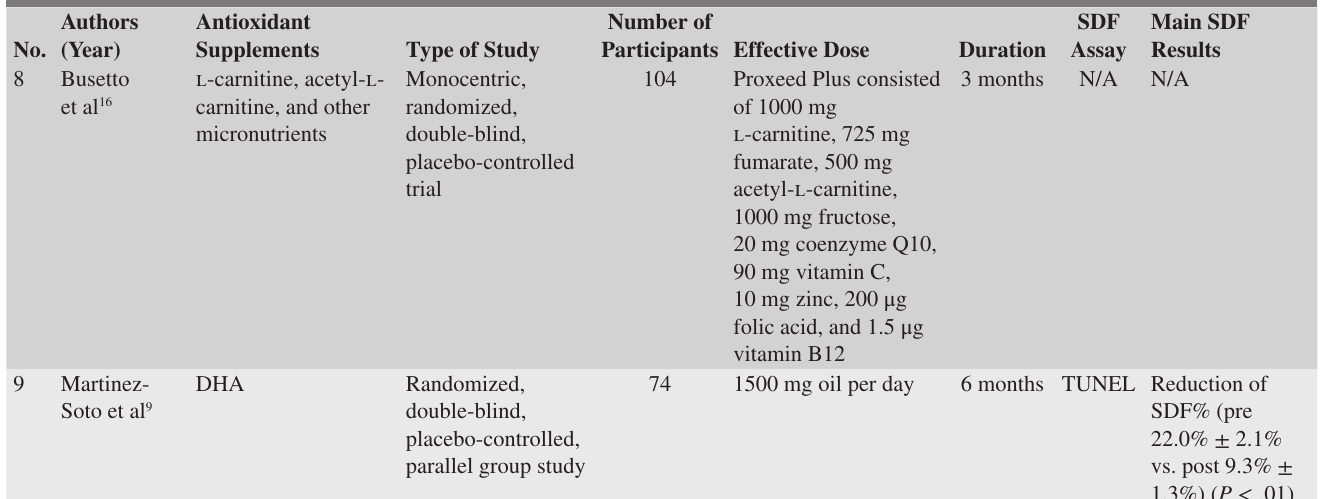
Table 1. Study Characteristics ( Continued